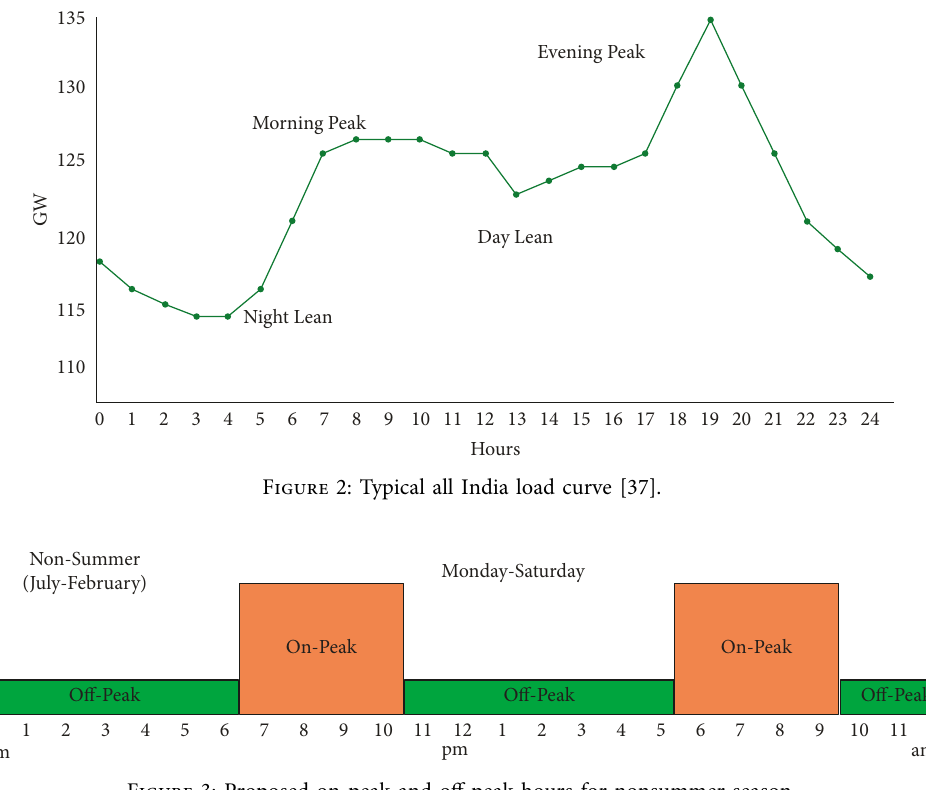
Figure 3: Proposed on-peak and off-peak hours for nonsummer season.